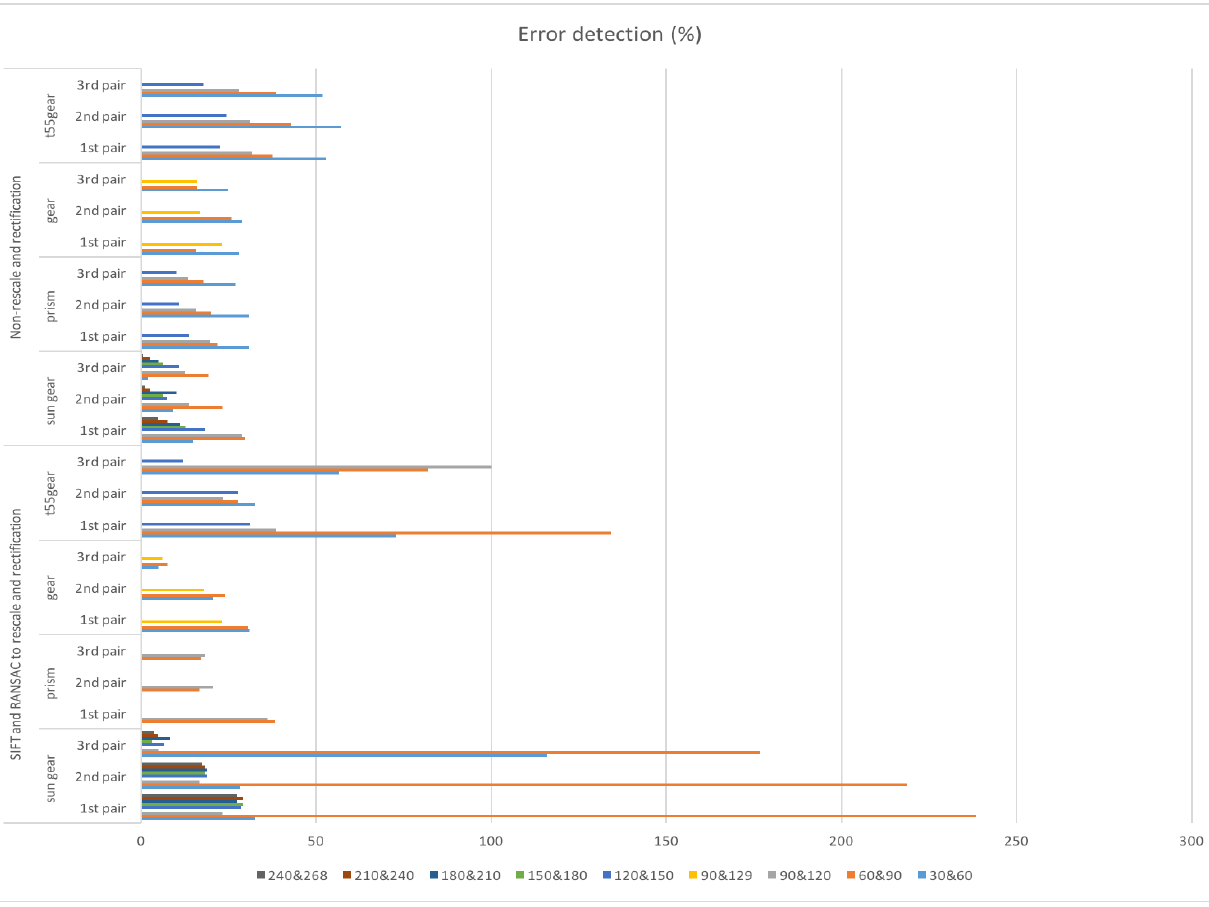
Figure A3. Summary of image pre-processing: the error detection of failure state for ( a ) sun gear; ( b ) prism; ( c ) gear; and ( d ) t55gear.